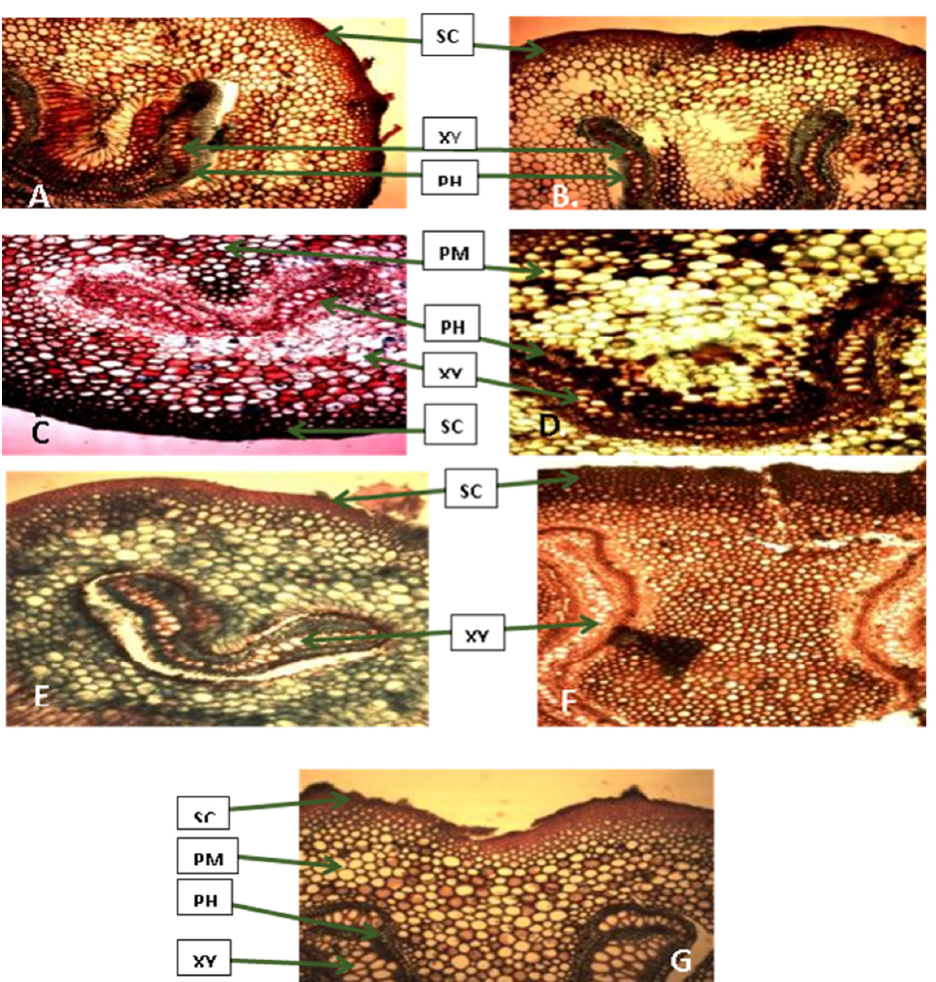
Figure 6. Transverse sections of distal regions of stipes showing cortex Pteris species. A : P. acanthoneura , B: P. atrovirens , C: P.ensiformis, D: P. mildbraedii, E: P. similis, F: P.togoensis , G P.